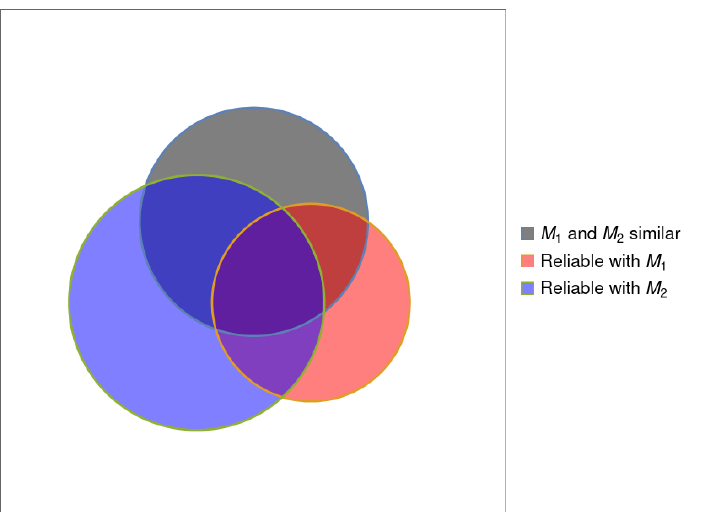
Figure 1. A schematic representation of the properties of the systems. The region within the square represents the set of all benchmark systems. The red disk represents the set of systems for which method M 1 is reliable. The blue disk represents the set of systems for which method M 2 is reliable. The gray disk represents the set of systems for which methods M 1 and M 2 give similar